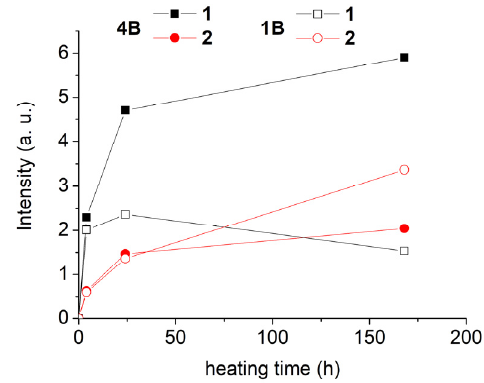
Figure 6. Intensity of H2,1 (black squares) and H2,2 (red circles) signals as a function of the heating time, as obtained from the 1 H HRMAS NMR spectra of B, 4B4, 4B24 and 4B168 (filled symbols) and of B, 1B4, 1B24 and 1B168 (empty symbols). The intensity value is relative to that of H2 protons of the non-degraded ionic liquid, which was set to 100 in all spectra.